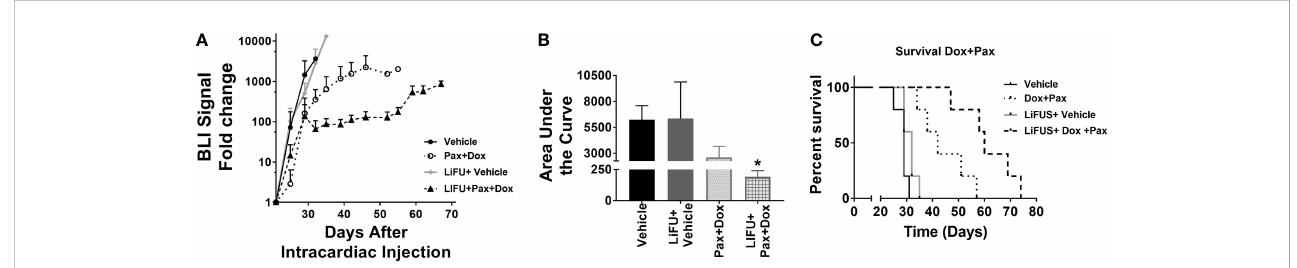
FIGURE 6 Concurrent therapy of LIFU with combination therapy of paclitaxel and Dox-NP decreases tumor burden and increases survival signi fi cantly in a preclinical model of brain metastasis of breast cancer. (A) BLI signal versus time in mice with treatment beginning on day 21 (n=5-7). Mice treated with 10mg/kg Pax or 5.6mg/kg Liposomal Dox (B) Area under curve (C) Kaplan-Meier survival plot of mice starting 21 days after intracardiac injection of MDA- MB-231Br breast cancer cells. *